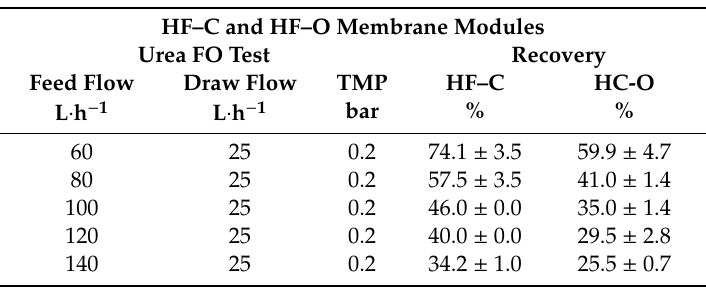
Table 5. Testing conditions used for investigation of the correlation between recovery and urea rejection in the FO